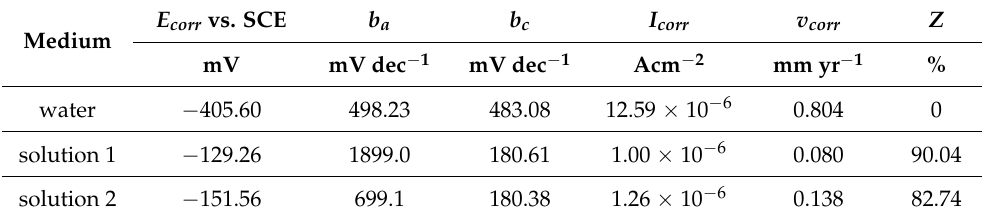
Table 4. Corrosion parameters of the tested HTCS-130 tool